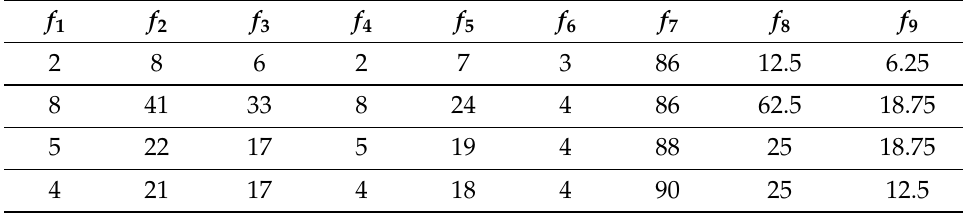
Table 1. Sample dataframe showing the features and four example data